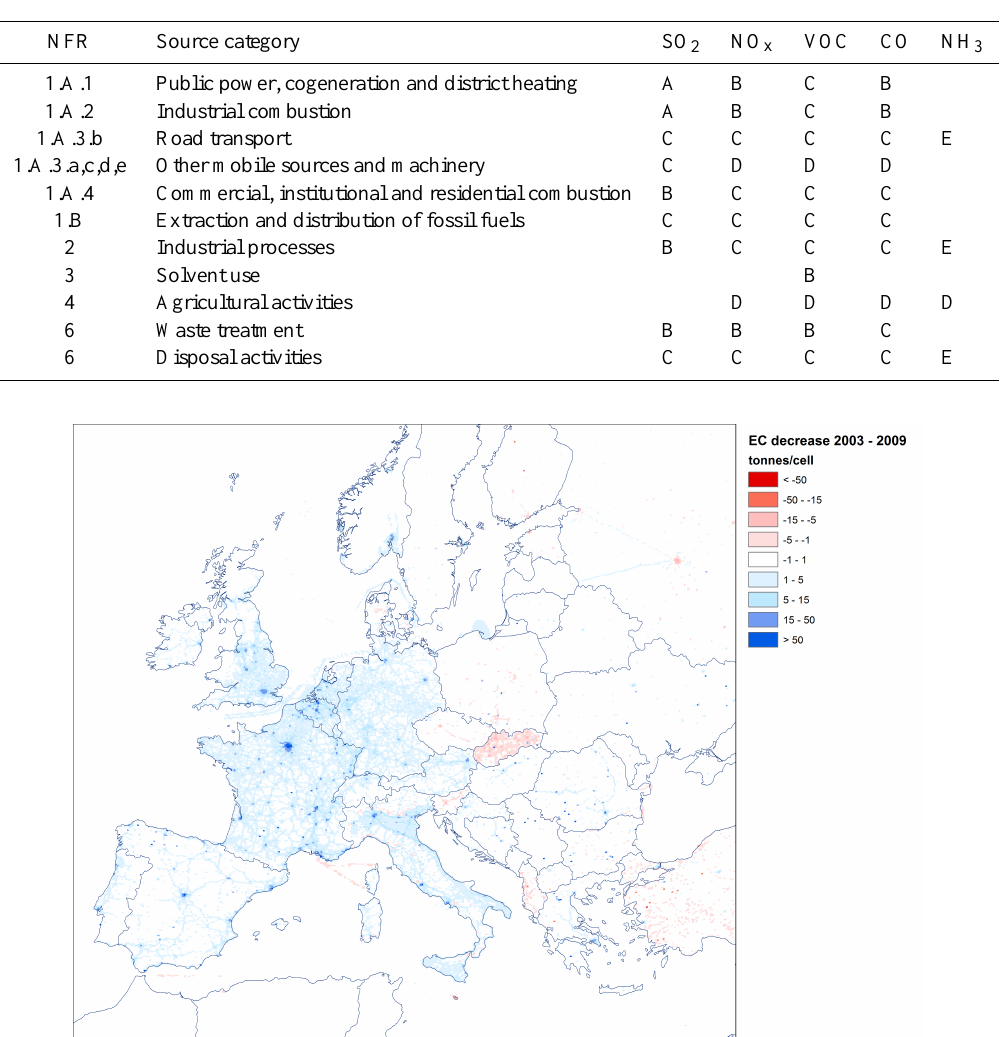
Table 5. Main relevant NFR source categories with applicable quality data ratings (source: EEA, 2013).